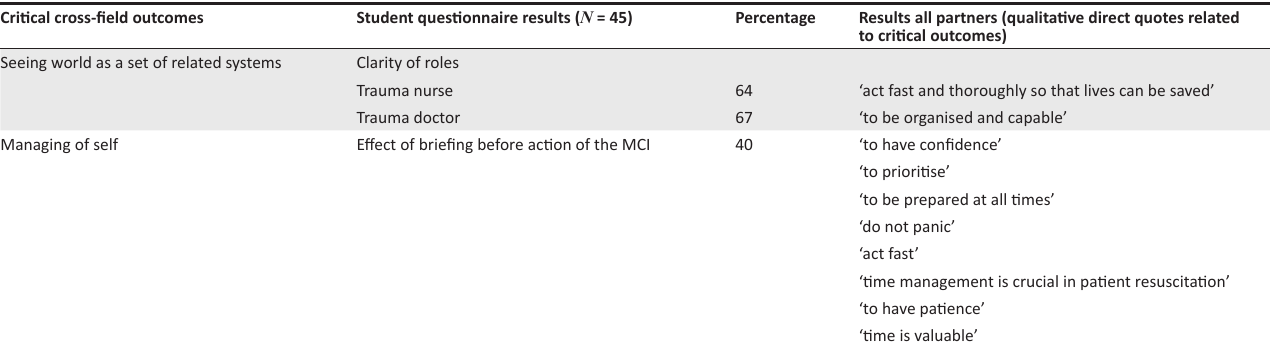
TABLE 6: Results of action research set two according to the critical cross-field outcomes (shortened version). Critical cross-field